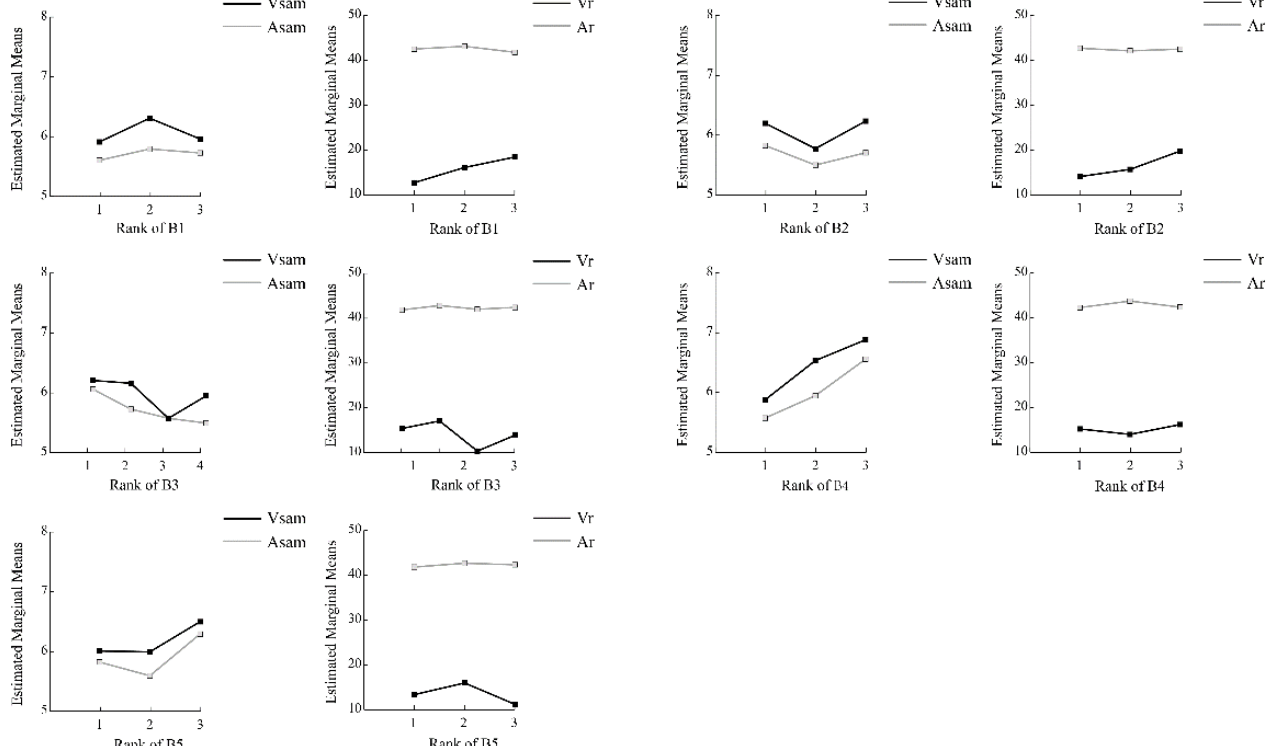
Figure 4. The extent of emotional responses differences of spatial structure attributes across the categories of scenes. Note: See Table 1 for the full abbreviations.